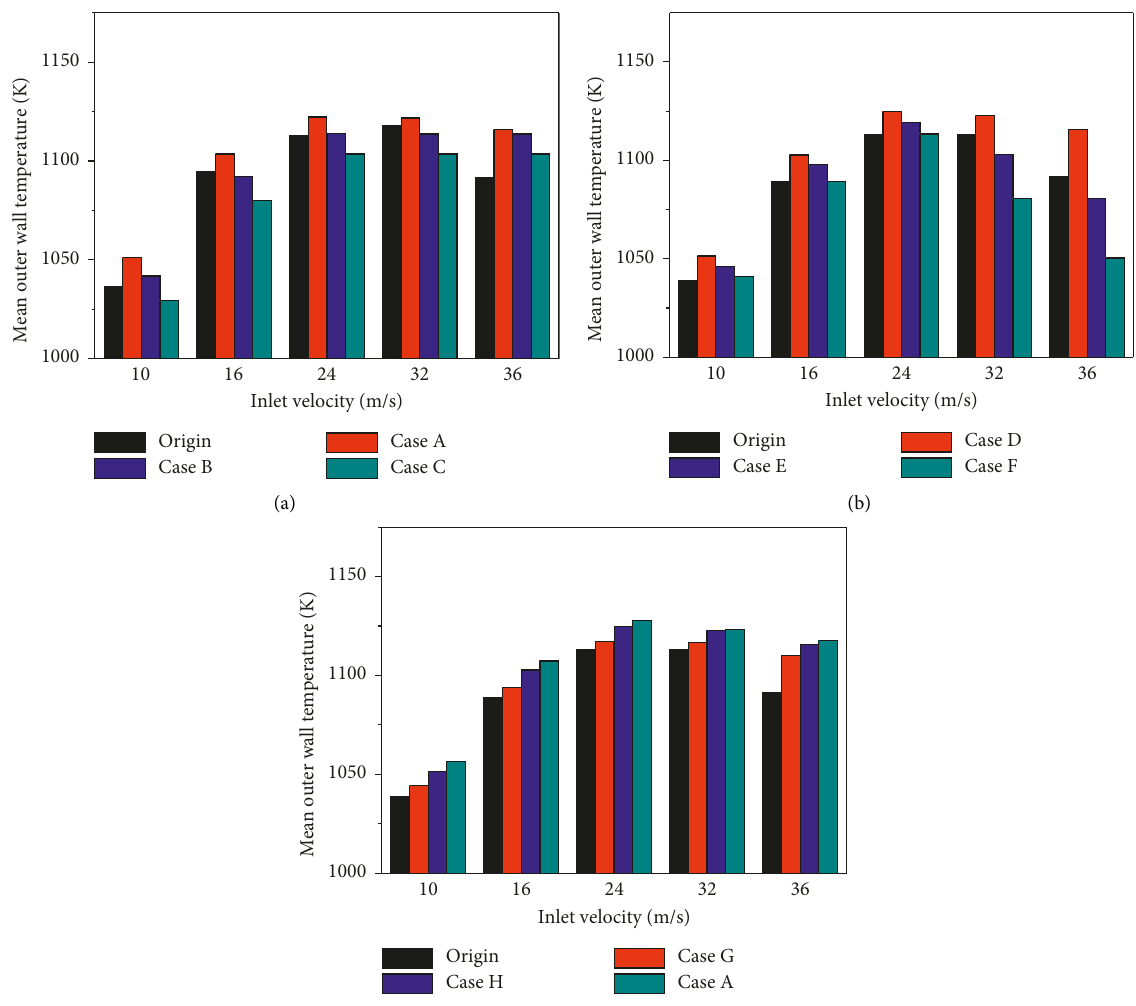
Figure 7: Average wall temperature versus inlet velocity for the combustor under Φ �